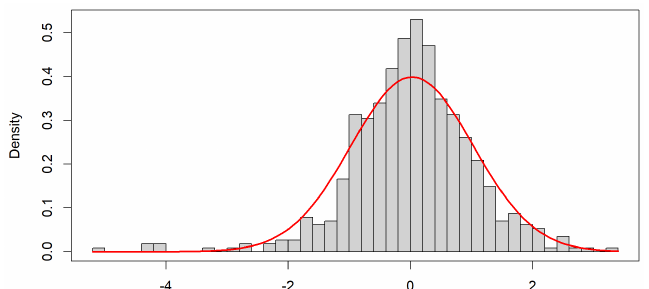
Figure 12. TGARCH Model Residual